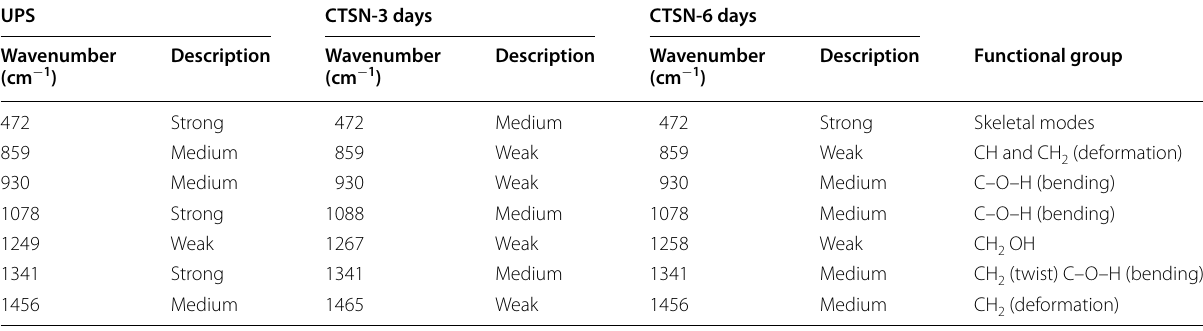
Table 7 Untreated potato starch (UPS) wavenumbers portrayed in Raman analysis with corresponding functional groups compared to chemically treated starch nanoparticles (CTSN-3 days and CTSN-6 days) absorption spectrum